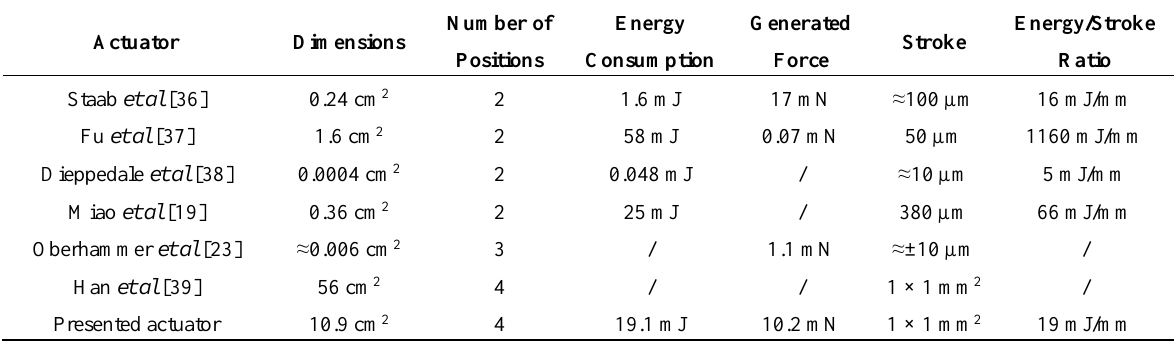
Table 4. Comparison of performances between existing and the presented